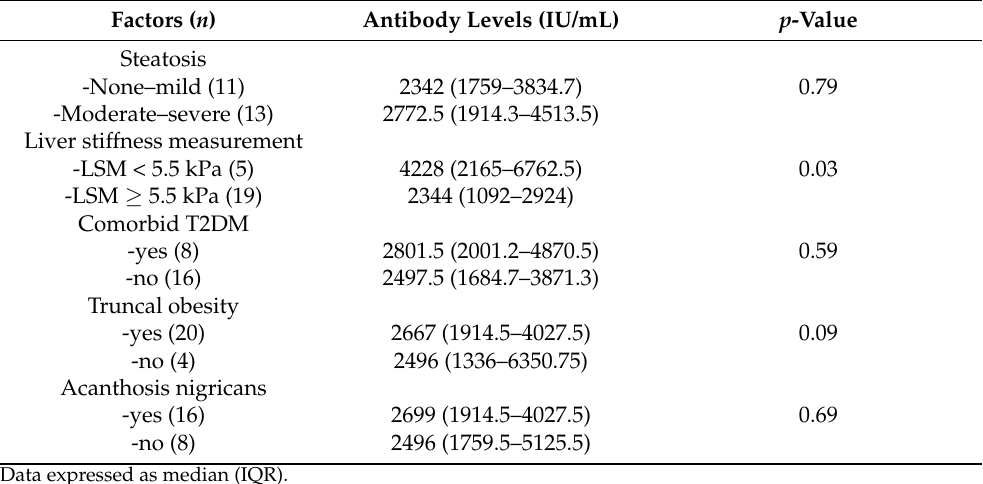
Table 3. Association between baseline characteristics and postvaccination antibody values in the obese adolescent group.